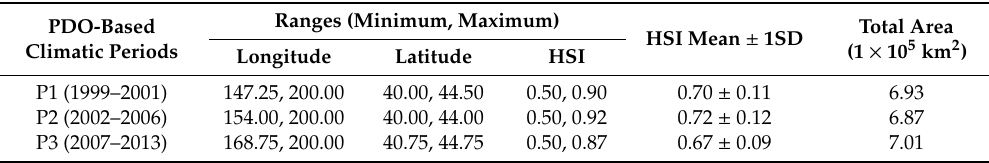
Table 5. Summary statistics of the spatial extent of inferred potential squid habitat across the di ff erent PDO periods. The total area with moderate to high potential squid habitat (HSI ≥ 0.5), overall habitat suitability (HSI) average and standard deviation (SD) were computed for each PDO-specific